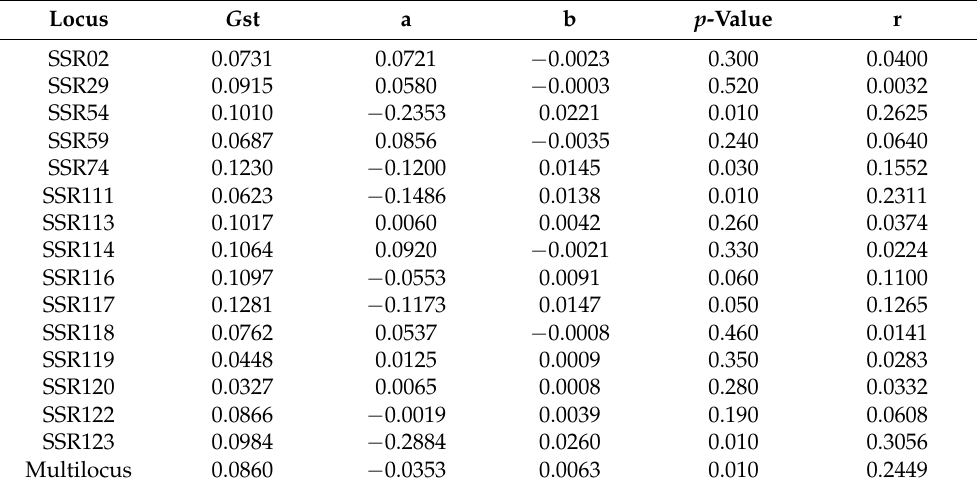
Multilocus 0.0860 − 0.0353 0.0063 0.010 0.2449 Note: all multilocus G ST values significantly differed from zero ( p < 0.001). In G ST /(1 − G ST ) = a + b ln(geographic distance), a and b refer to the intercept and regression coefficient, respectively; r refers to the Pearson’s correlation